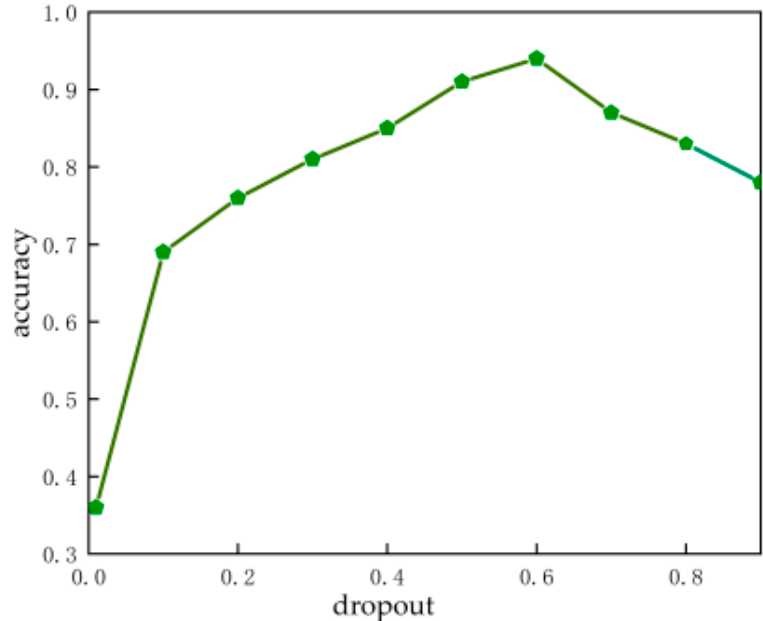
Figure 6. Effect of the dropout ratio on accuracy.